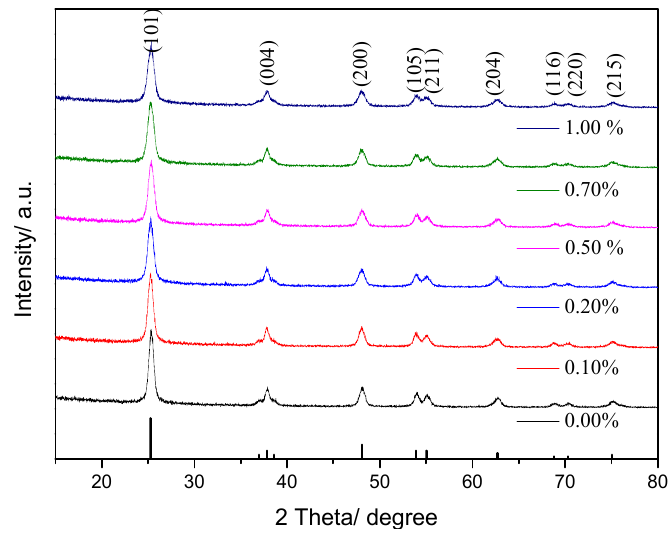
Figure 1. XRD ( X-ray Diffraction) patterns of Yb/TiO 2 with different doping amounts, calcined at 450 °C.